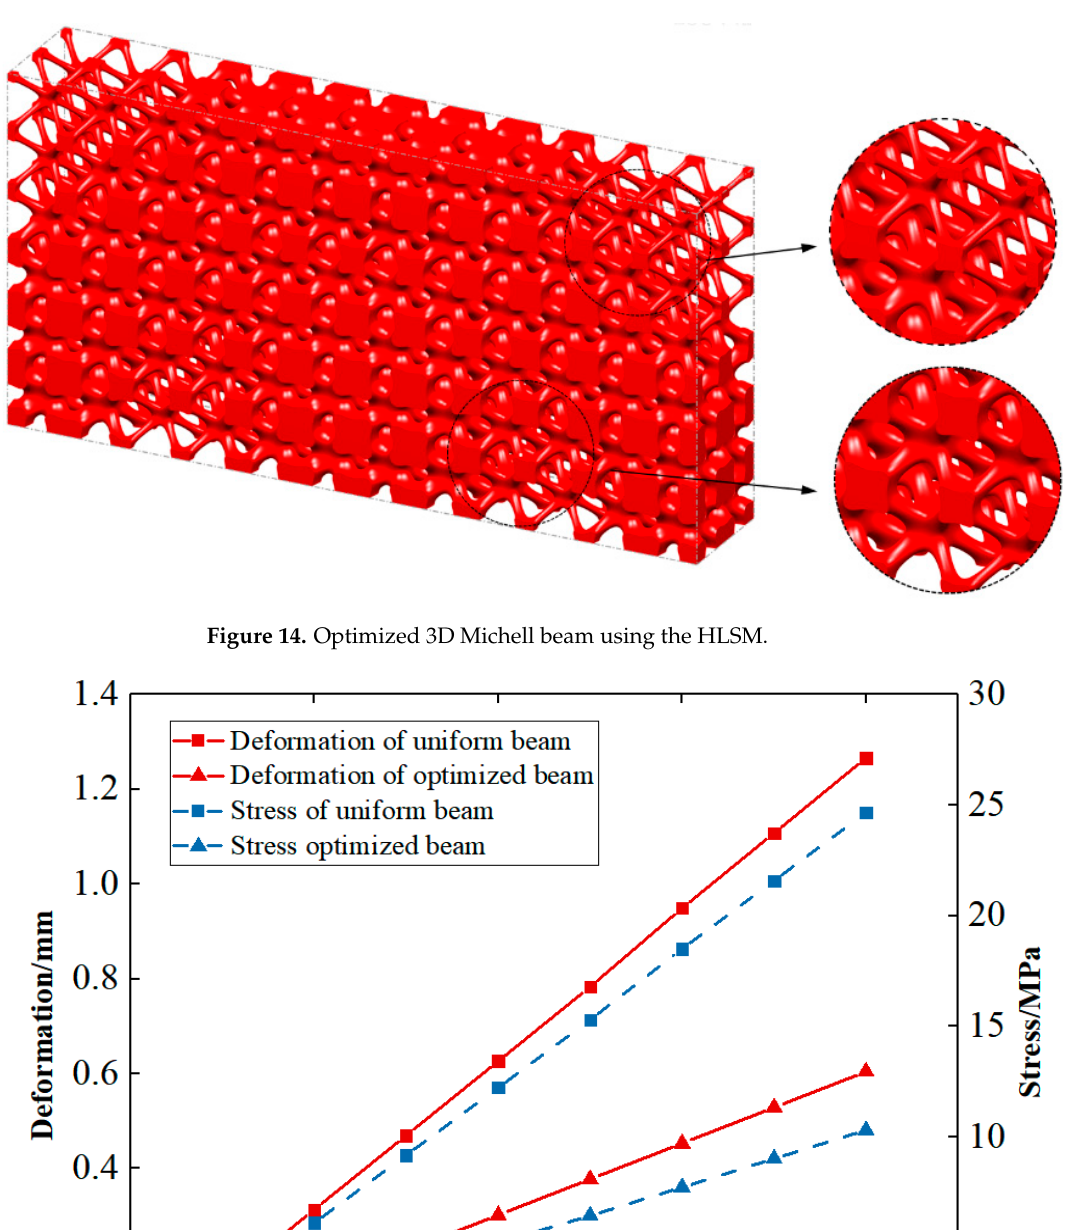
Figure 13. Interaction history of 3D Michell beam design.